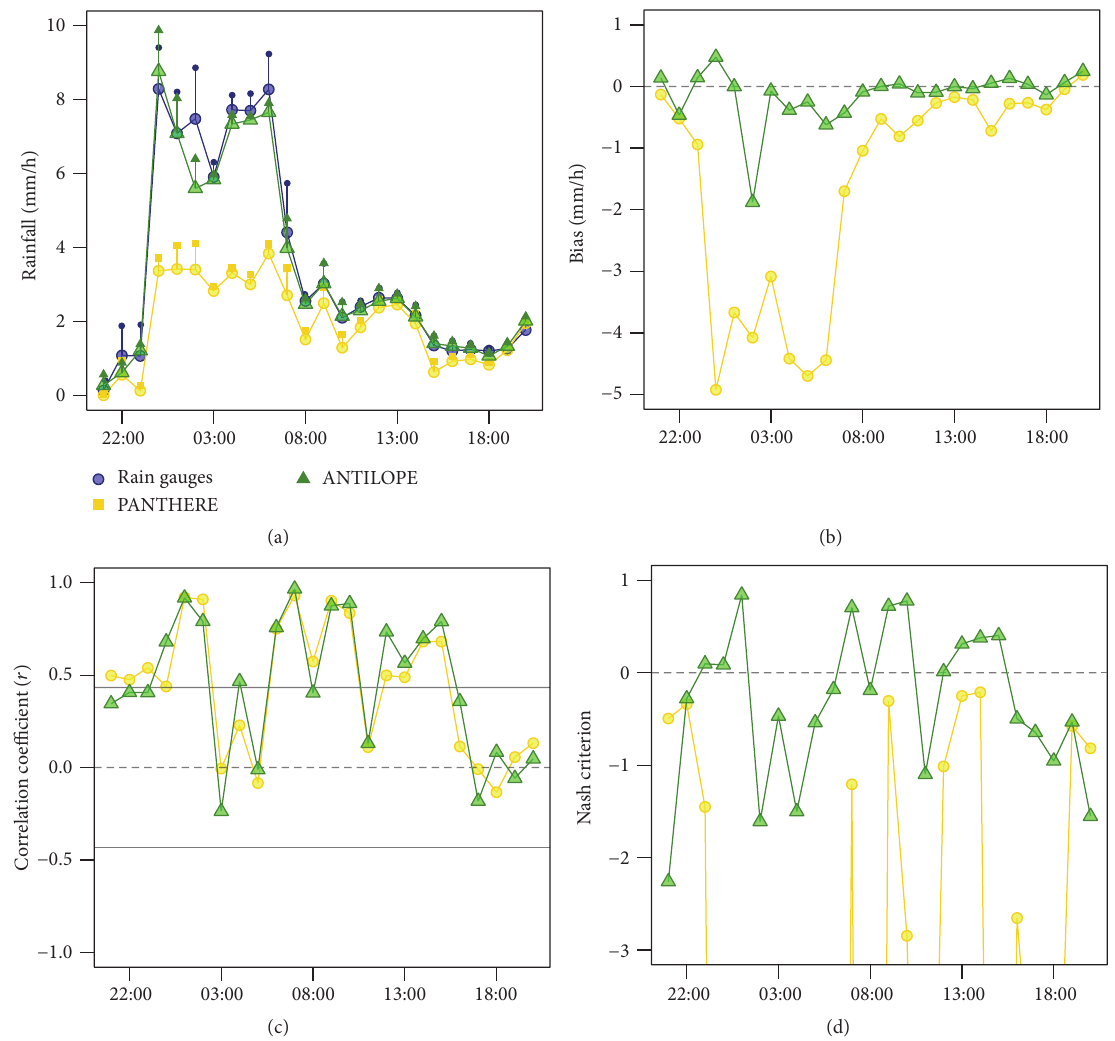
Figure 5: Hourly statistics for radar-derived products and HydraVitis rain gauges ( 𝑁 = 21 pixels/rain gauges). (a) Hourly rainfall averaged for 21 pixels (rain gauges) at local scale. Vertical bars indicate the standard deviation (i.e., spatial variability). (b) The mean difference between radar-derived products and rain gauges. (c) Pearson correlation coefficients. The solid grey horizontal lines indicate the value corresponding to statistically significant 𝑟 (Student dist., 𝑝 value = 5%). (d) Nash criterion. Light green triangles and yellow circles, respectively, represent ANTILOPE and PANTHERE